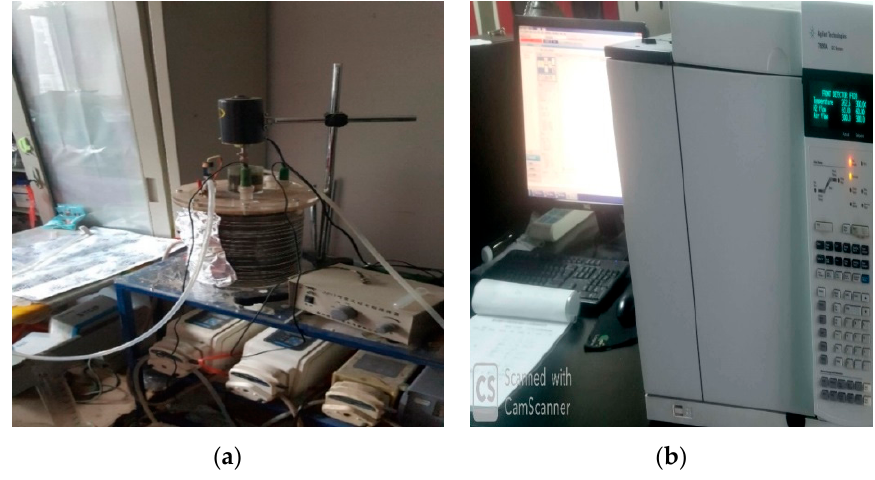
Figure 1. ( a ) Anaerobic continuous stirred tank reactor (CSTR) reactor; ( b ) gas chromatography machine.